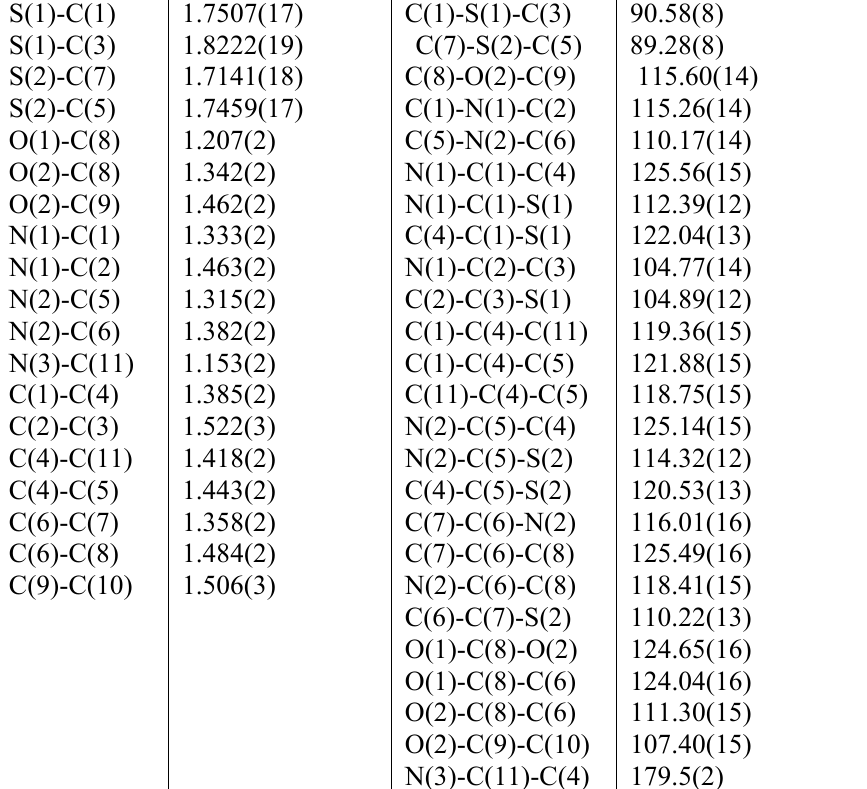
Table 3. Selected bond lengths [Å] and angles [°] for compound 5a